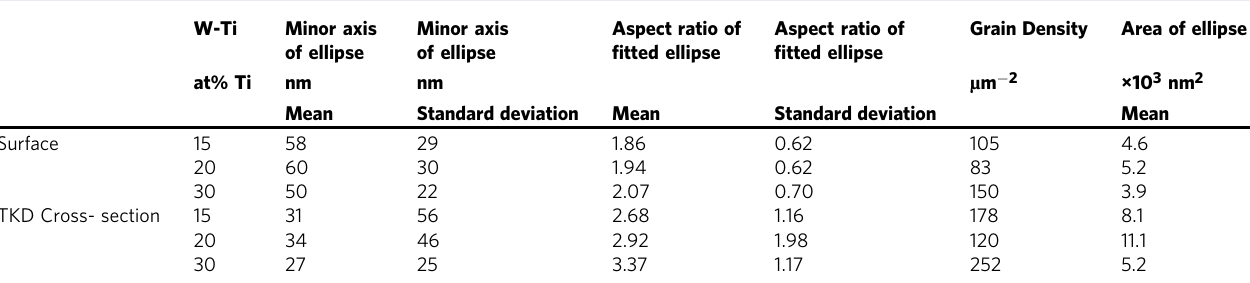
Table 1 FESEM-EBSD surface (x-y plane) and FESEM-TKD cross-section (x-z) grain analysis illustrating the mean value and standard deviation for the minor axis, aspect ratio and mean area of the fi tted ellipses as well as the grain